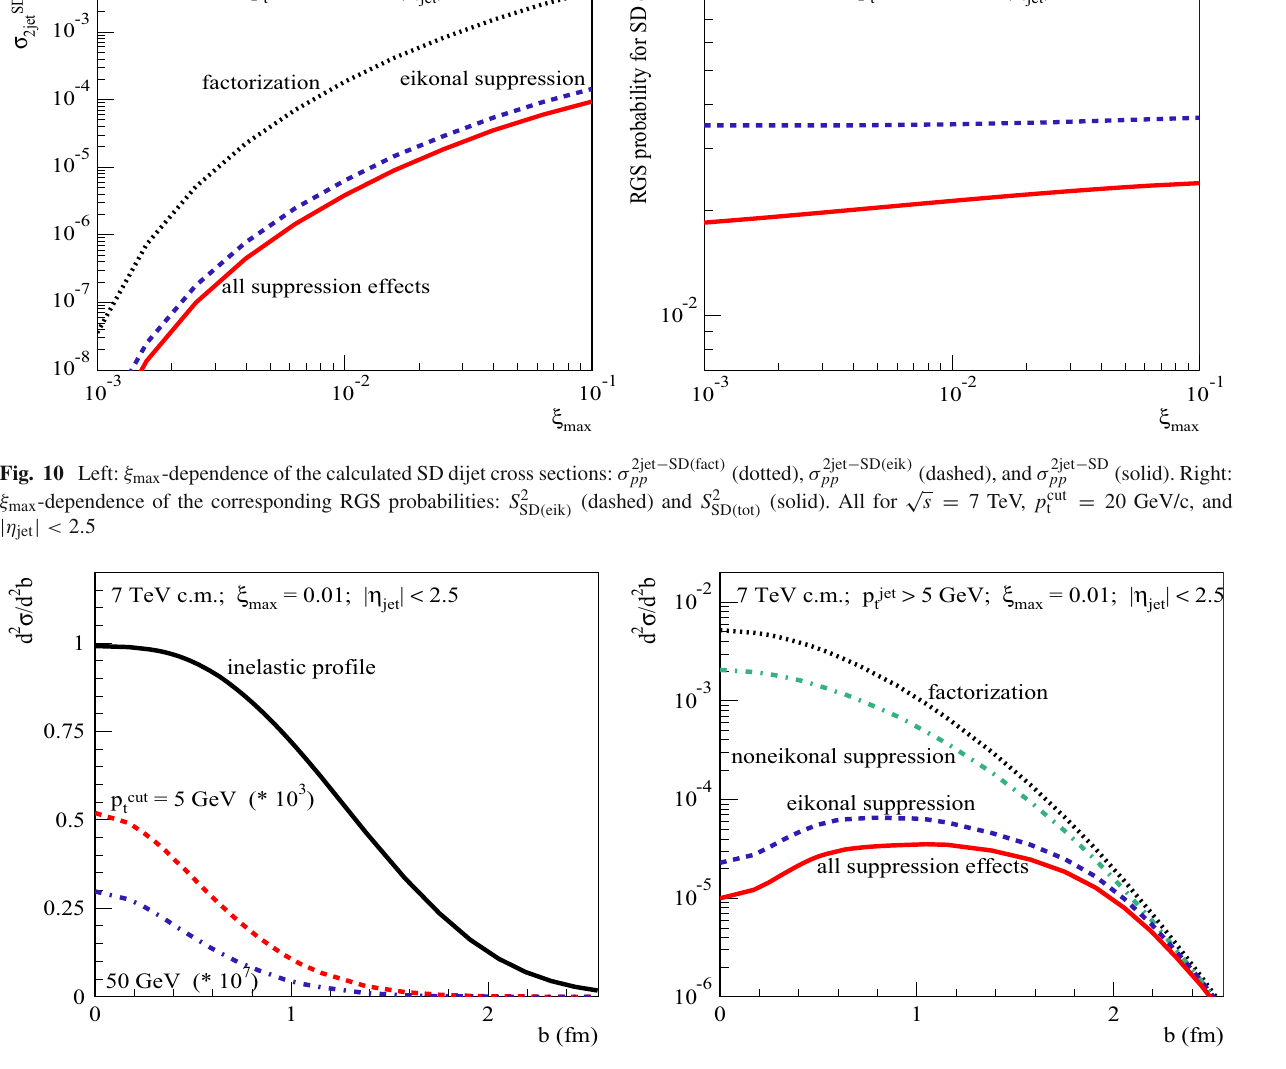
calculated taking different absorptive effects into account; dotted, dotted-dashed, dashed, and solid lines correspond, respectively, − SD ( fact ) / d 2 b , d 2 σ 2jet − SD ( noneik ) / d 2 b , d 2 σ 2jet − SD ( eik ) / d 2 b , to d 2 σ 2jet pp pp pp √ − SD / d 2 b .Allfor s = 7TeV, ξ max = 0 . 01,and | η jet | < 2 . and d 2 σ 2jet pp